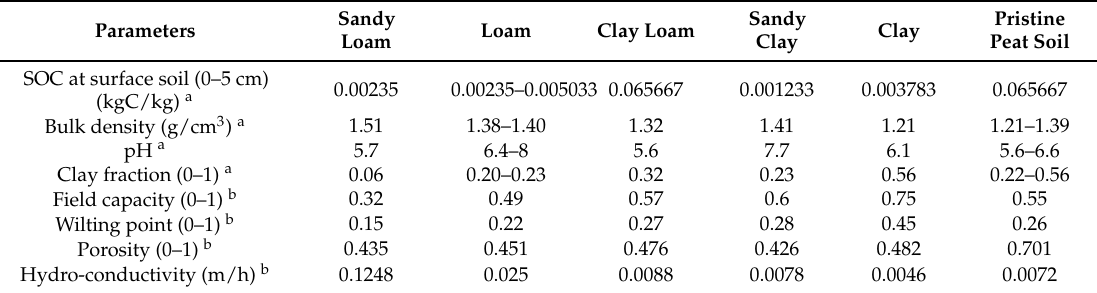
Table 2. Values of input soil parameters used in the DNDC